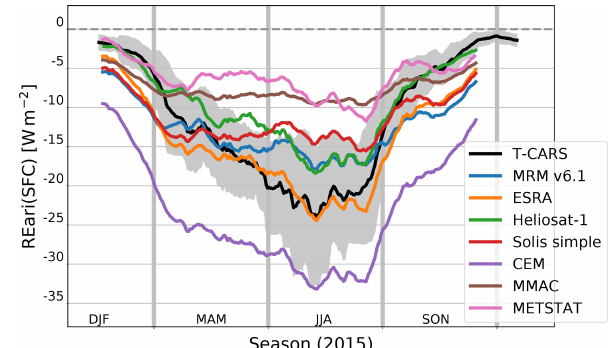
Figure 8. The 30d rolling mean of REari in the year 2015 utilizing different approaches. The shown REari values are computed as the mean over all DWD stations, while cloudy days are linearly inter- polated over the year. The REari from T–CARS is simulated with collocated input to all DWD stations. In addition, for T–CARS, the 30d rolling standard deviation (grey area) is